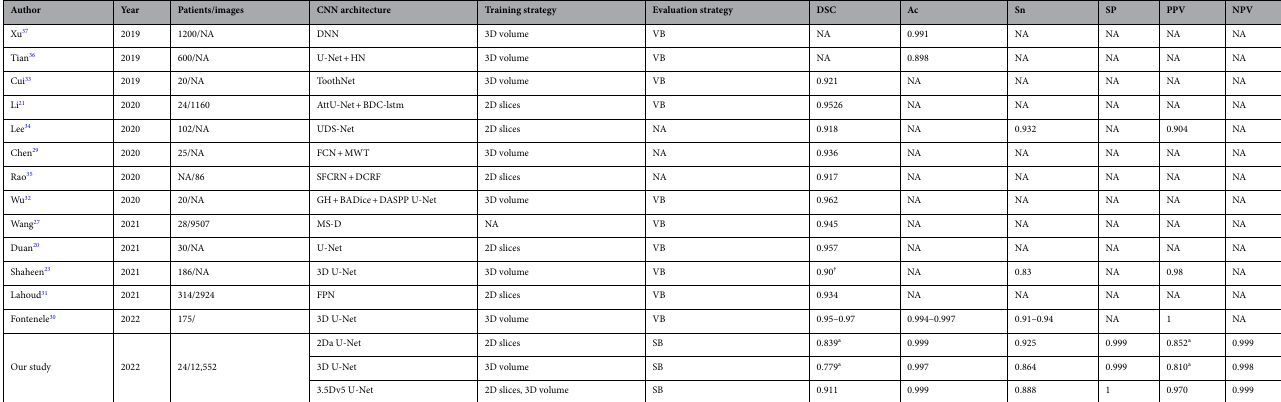
Table 3. Comparison of segmentation of human teeth on CBCT using CNN. Numerical data are presented as mean value. BADice boundary aware dice loss, BDC-LSTM bidirectional convolution long short-term memory, DASPP densely connected Atrous spatial pyramid pooling, DCRF dense conditional random field, FCN fully convolutional network, FPN feature pyramid network, GH Gaussian heatmap localization, HN hierarchical network, LO label optimization, MS-D mixed-scale dense, MWT marker-controlled watershed transform, NA not available, PB volume-based, SB slice-based, SFCRN symmetric fully convolutional residual network, UDS-Net U-Net added by dense block and spatial dropout. a Data acquired after erosion and dilation of mathematical